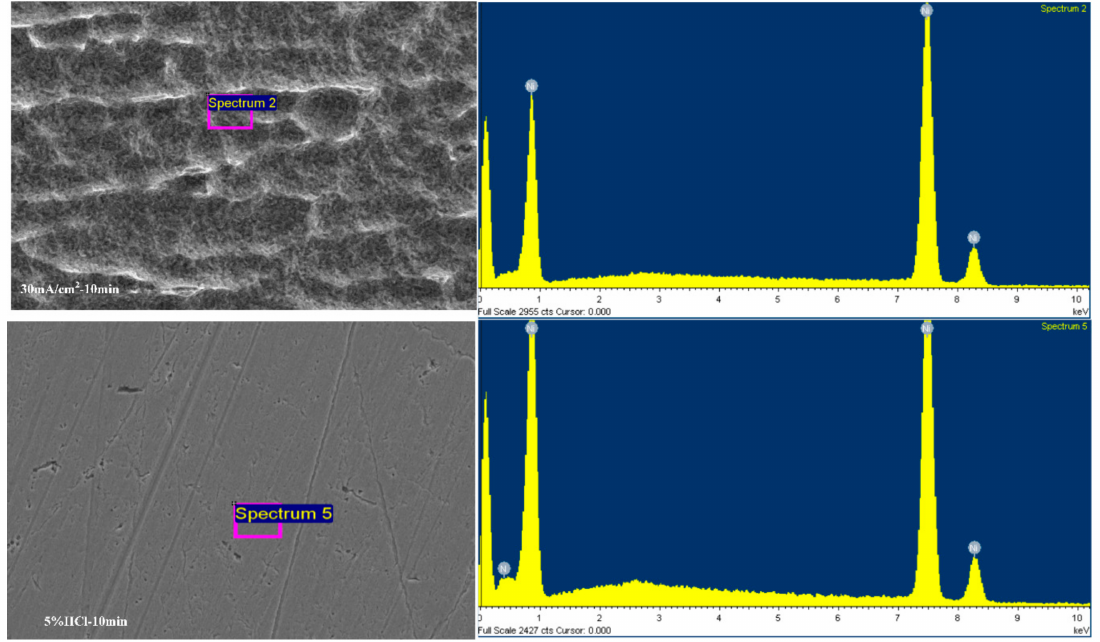
Figure 9. Energy dispersive X-ray spectroscopy (EDS) results of the metal Ni films treated with both methods: anodic current density of 30 mA/cm 2 with 10 min and 5 vol % HCl with 10